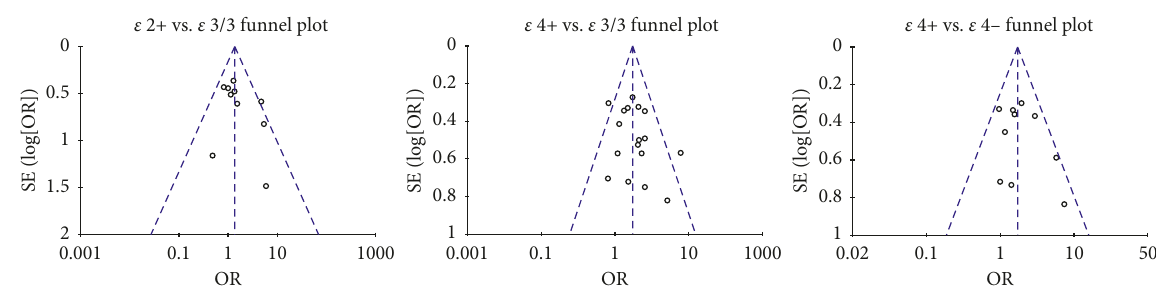
Figure 9: Funnel plots of ε 2+ vs. ε 3/3, ε 4+ vs. ε 3/3, and ε 4+ vs. ε 4